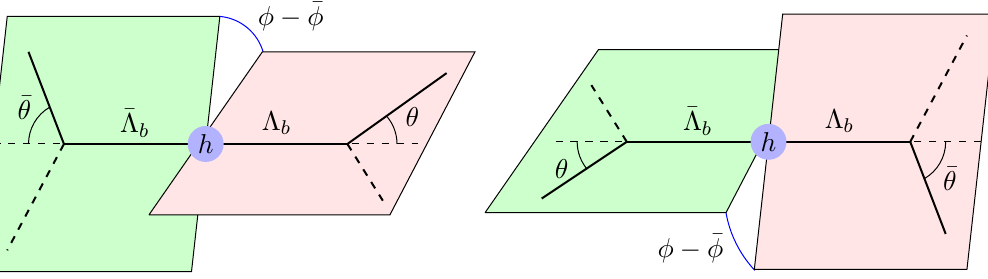
Figure 4 . CP transformation under which θ ↔ ¯ θ and φ → ¯ φ + π , ¯ φ → φ + π . The polar angle is defined with respect to the axis given by the Λ b